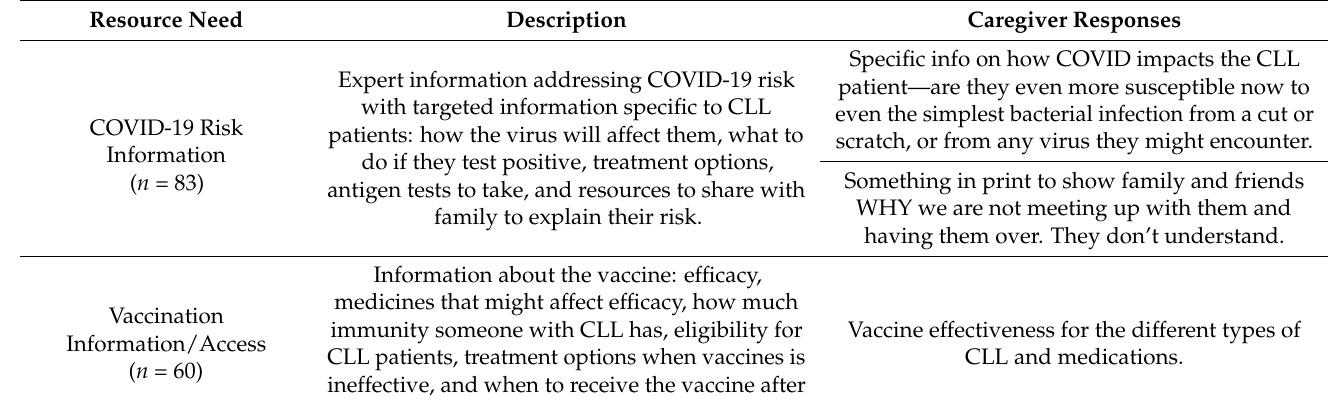
Table 2. Resource Needs Identified by CLL Caregivers During the COVID-19 Pandemic (as of March